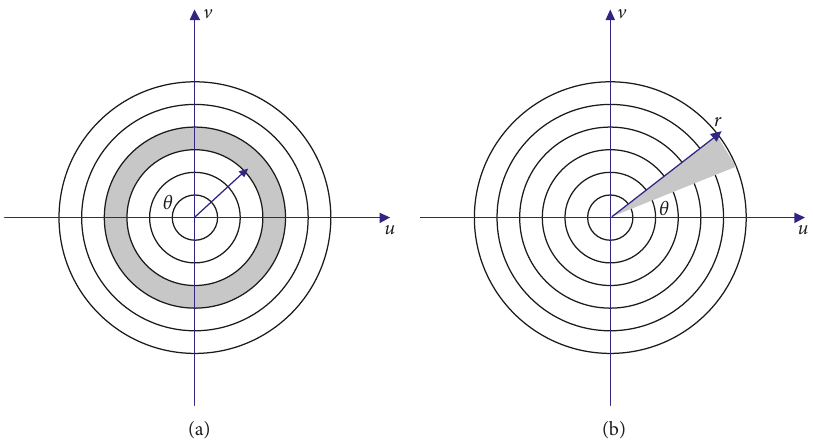
Figure 1: Spectrum energy statistical schematic diagram: (a) radial spectrum energy and (b) angular spectrum